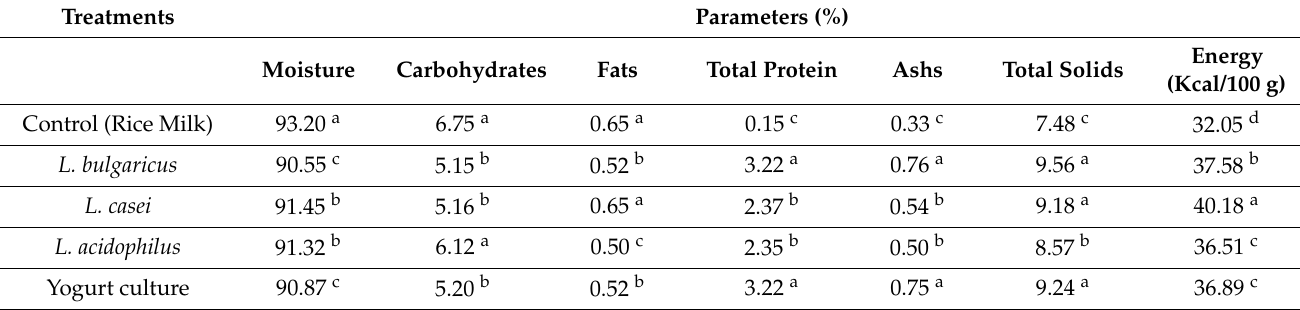
Table 2. Chemical properties of fermented rice milk